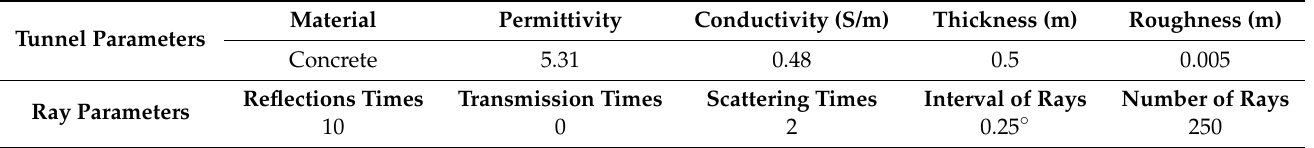
Table 2. WI simulation parameter settings.